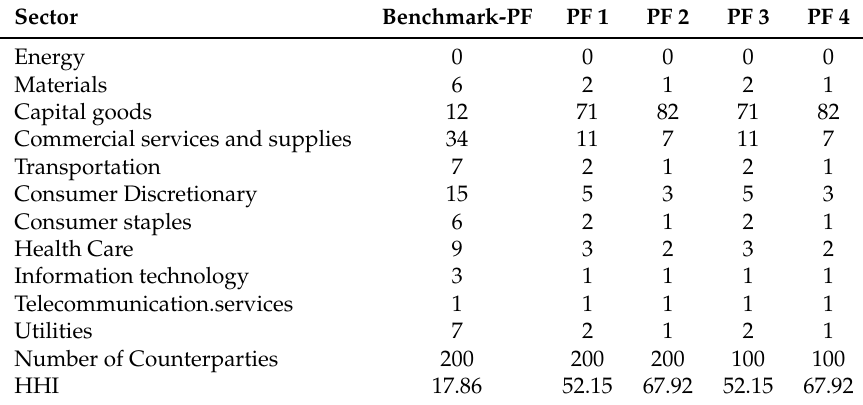
Table 3. Relative sector concentration.